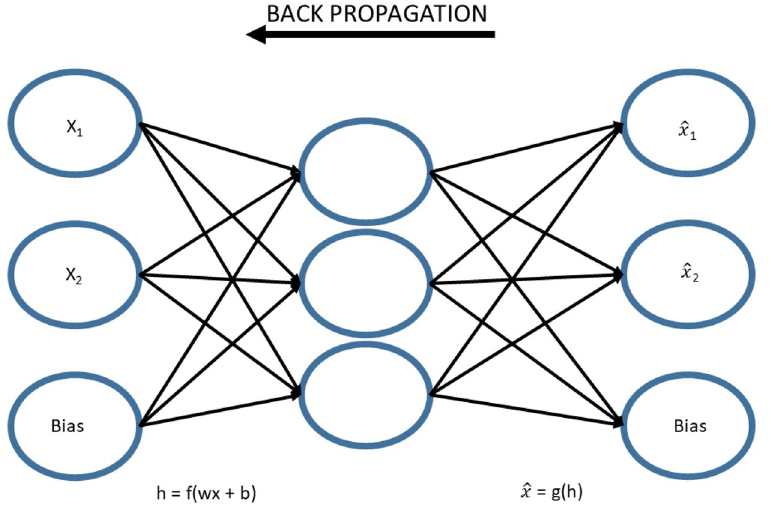
Figure 4. Basic architecture of sparse